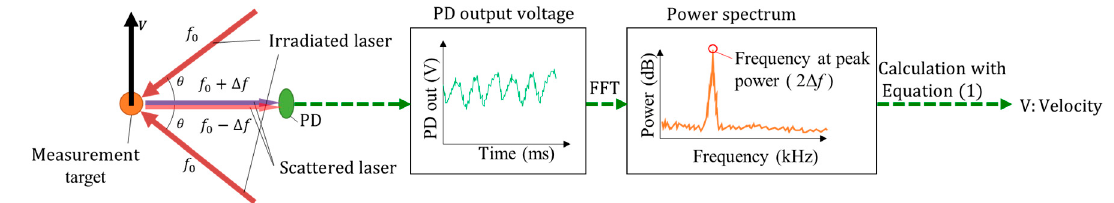
Figure 2. Schematic of the principle of laser Doppler velocimeter and signal processing.